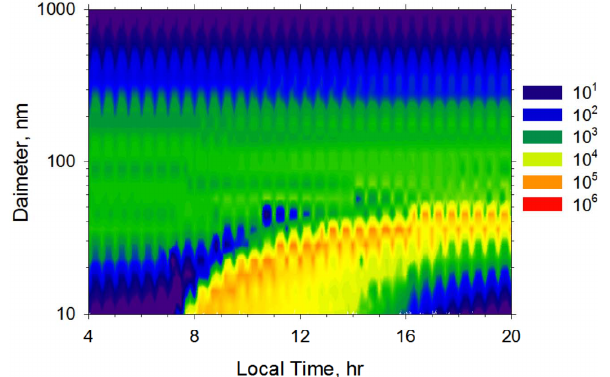
Fig. 8. Same as Fig. 5, but for the turbulence eddy scenario corre- sponding to Fig.